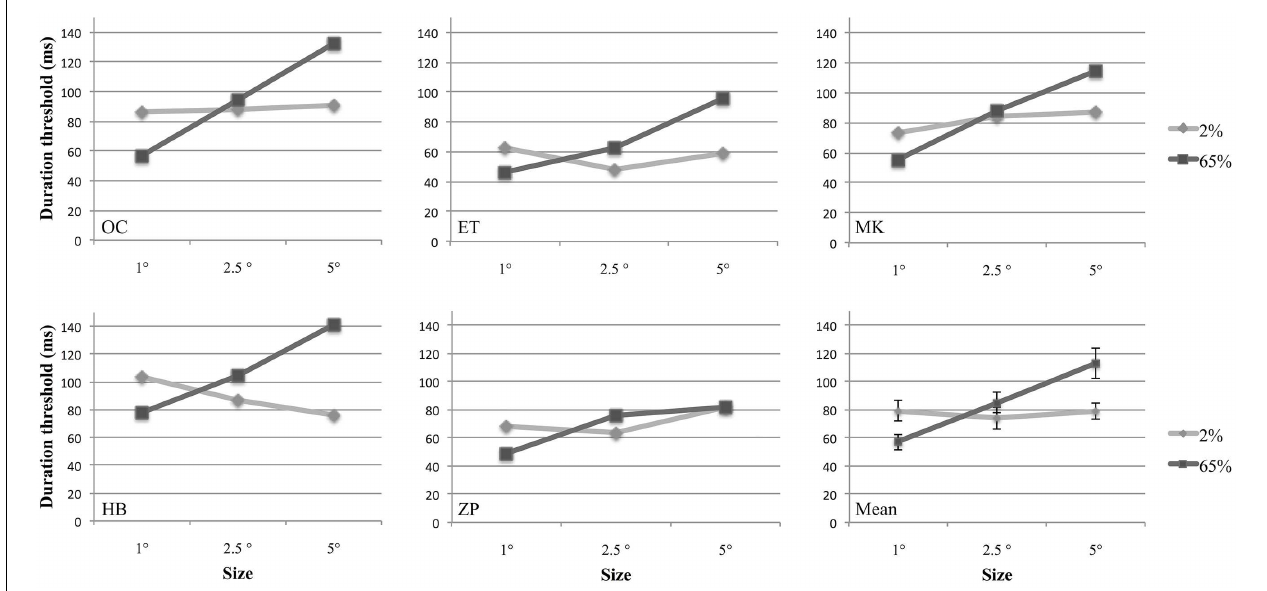
FIGURE 2 | Duration thresholds of five participants and the group means plotted as a function of stimulus size at 2 and 65% contrasts. In the last figure (Mean), individual data points are averages of five participants. Error bars represent 1 SEM calculated across subjects.